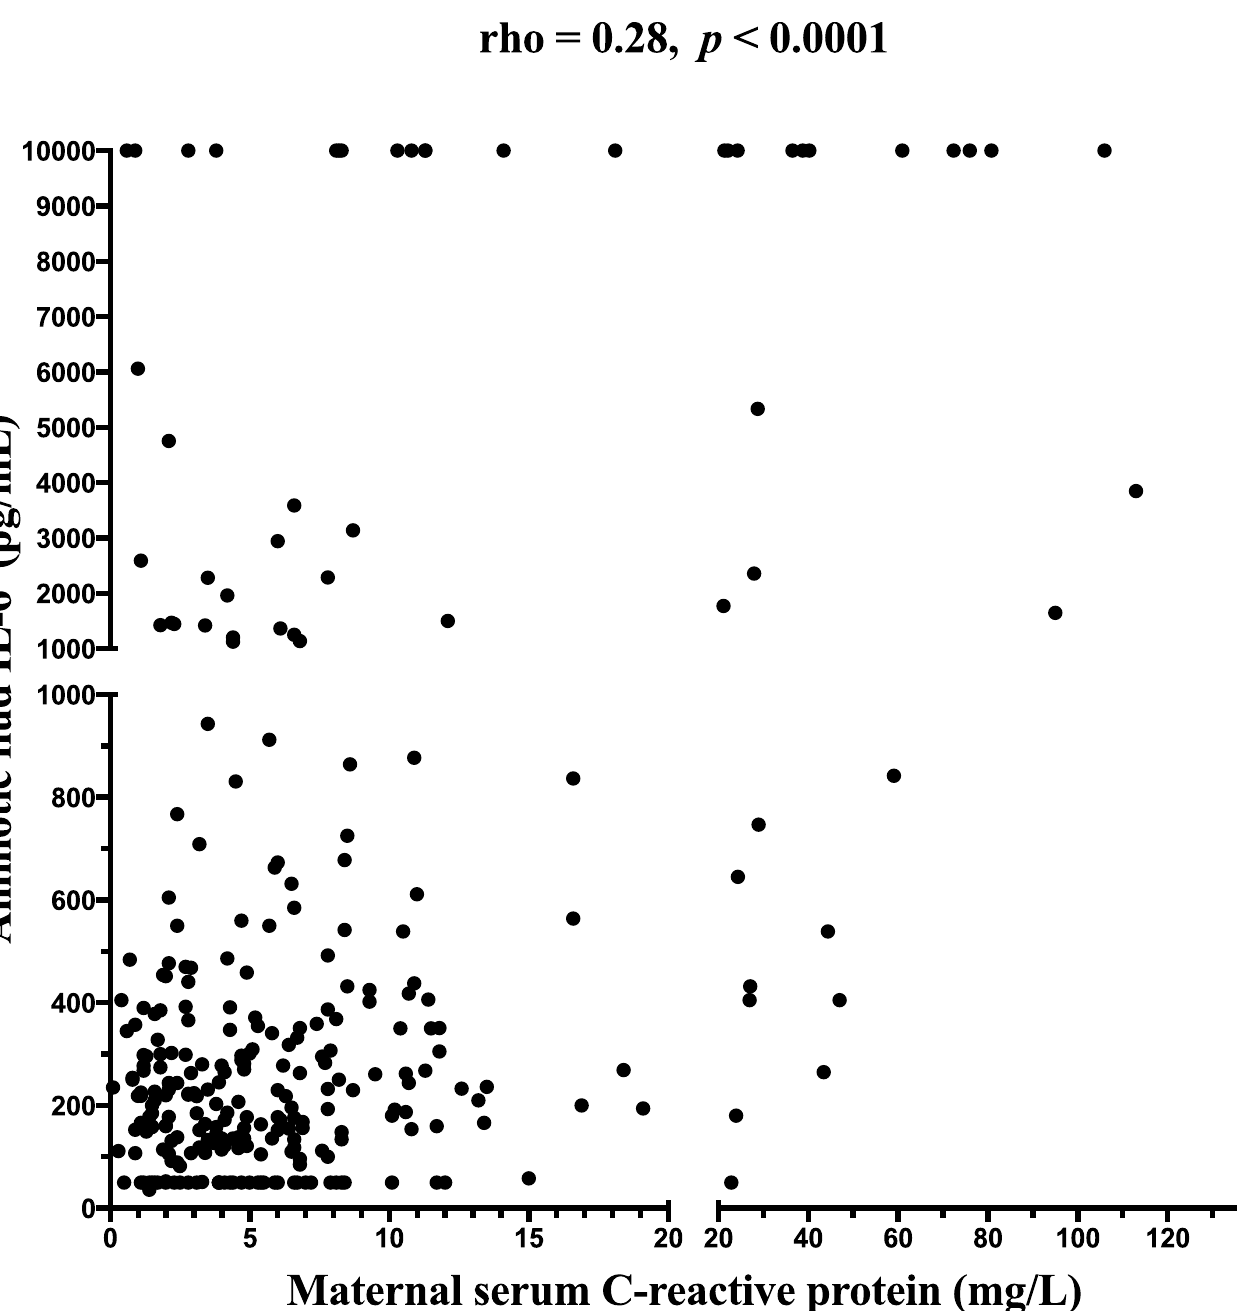
Fig 5. A correlation between maternal serum C-reactiveprotein and amniotic fluid IL-6 concentrations.